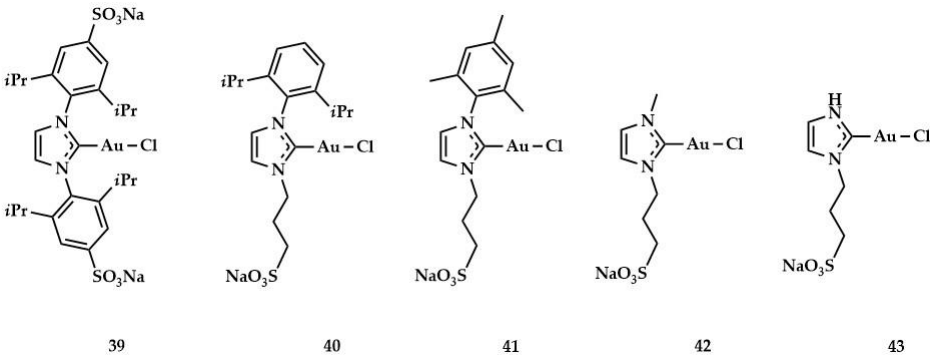
Figure 17. Structure of gold(I) sulfonated NHC complexes of Silvestri et al. [44,45].